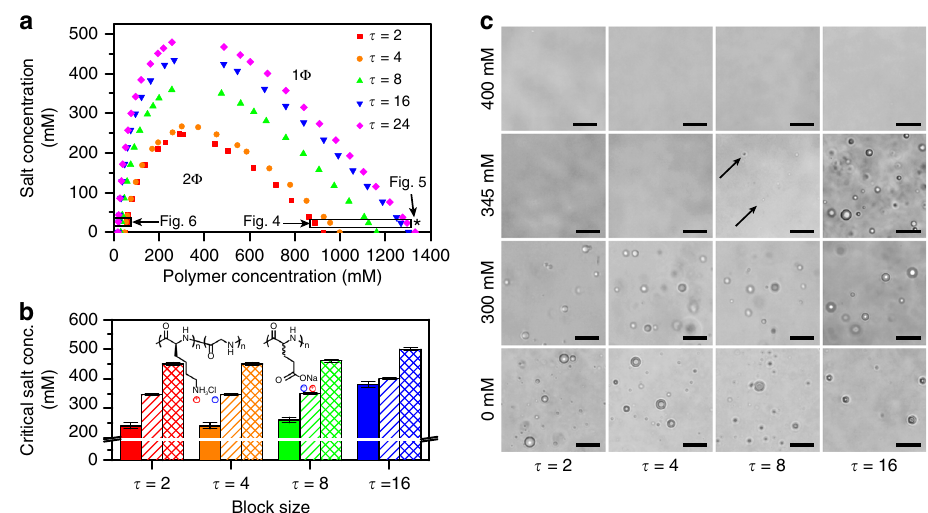
Fig. 2 Coacervate phase behavior is affected by charge sequence in both simulation and experiment. a Simulations demonstrate that the size of the coexistence region 2 Φ increases with τ . Simulation conditions for Figs. 4 – 6 are speci fi ed by asterisks/boxes, which denote points along the binodal curves at 25 mM NaCl. These points are considered, because the salt concentration values correspond to those used for isothermal titration calorimetry. b The experimental critical salt concentration (CSC) for sequence-de fi ned coacervates at a variety of total charged monomer concentrations (solid 1 mM, stripes 5 mM, crosshatch 50 mM), plotted as a function their periodic block size ( τ = 2 to τ = 24). Increasing τ leads to a marked increase in the CSC, qualitatively changing by as much as 50 – 150 mM, consistent with simulations in a . Error bars re fl ect the intervals between samples in these experiments. c A selection of optical micrographs corresponding to the data in a , highlighting that the region of coacervation increases with τ . Arrows indicate the presence of tiny coacervate drops. Scale bars are 25 μ